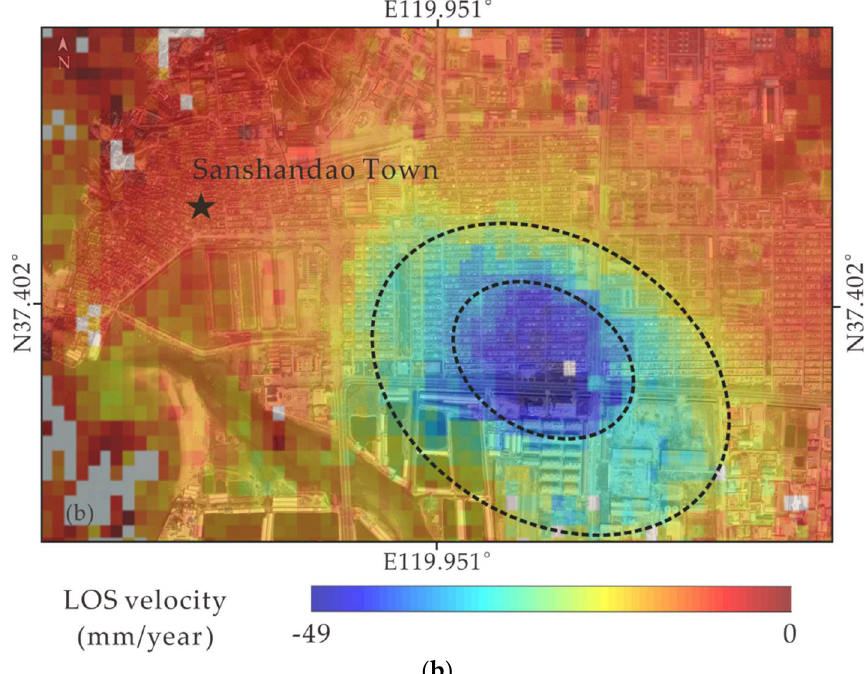
Figure 9. The subsidence funnel in the main mining area: ( a ) PSI result: ground movements away from the satellite are shown with cold colors; ( b ) SBAS result: ground movements away from the satellite are shown with cold colors.